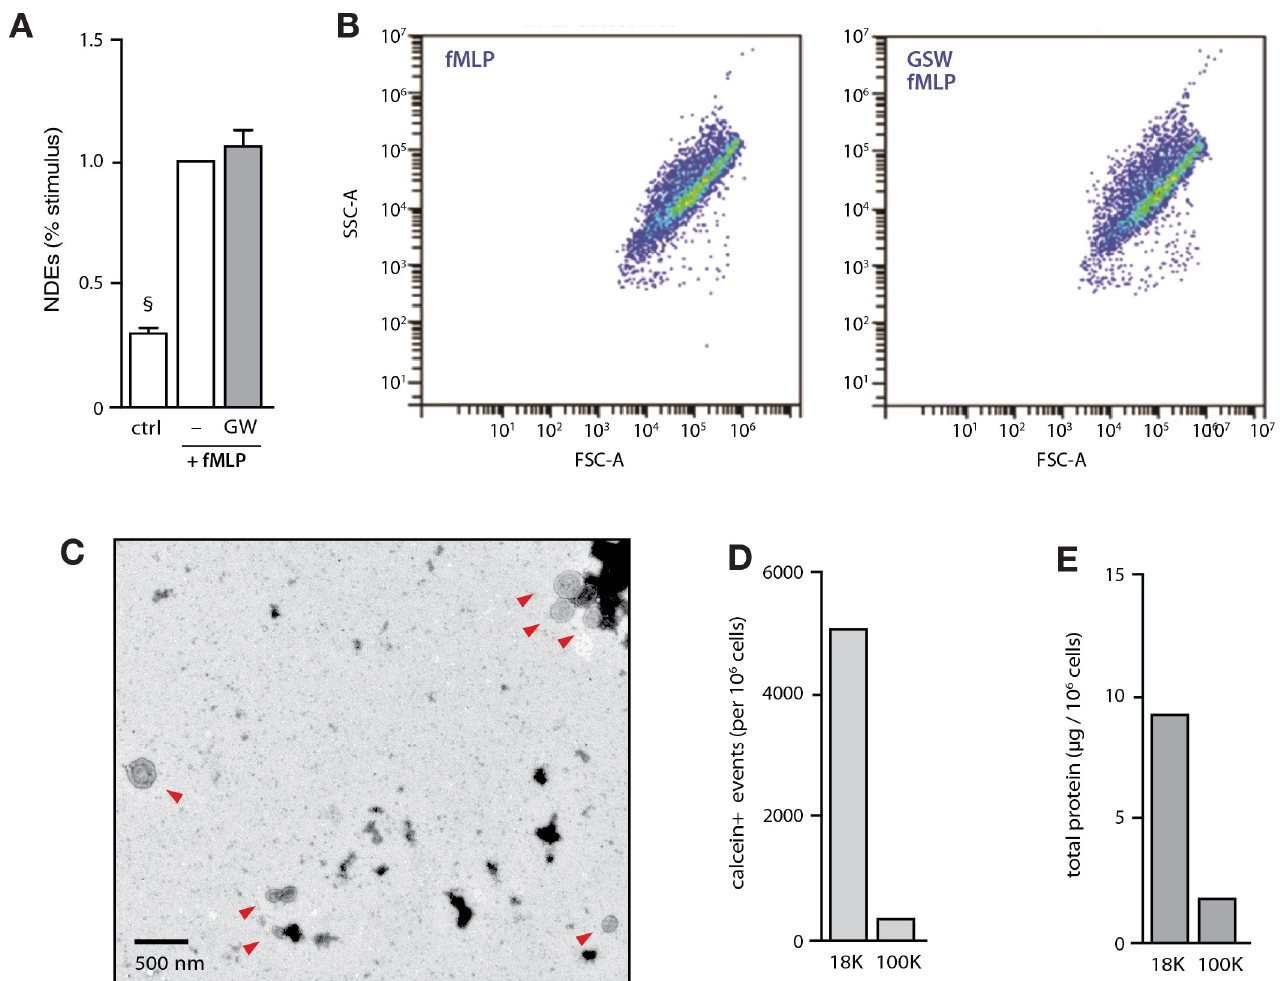
Figure 2. Isolation and properties of NDEs released by cultured neutrophils. ( A ) Neutrophils were cultured (15 min, 37 °C) in the presence of 20 µM GW4869 (or its diluent, 0.1% DMSO) prior to further incubation in the absence (“ctrl”) or presence of 100 nM fMLP for 120 min. Culture supernatants were collected, and NDEs were isolated and counted as described in Methods. Mean ± s.e.m. from 3 independent experiments. §, p < 0.01 vs fMLP-stimulated cells. ( B ) Detail of the flow cytometry analysis of the NDEs described in panel A, following the steps described in Figure 1A–C. Calcein Blue-positive events are shown. The experiment depicted is representative of three. ( C ) Transmission electron micrograph of isolated NDEs from fMLP-stimulated cells. Red arrows point to intact vesicles. The experiment depicted is representative of three. ( D ) Culture supernatants from neutrophils stimulated for 60 min with 100 nM fMLP were centrifuged at 1000 g; the resulting supernatants were centrifuged at 18,000 g and the pellets (“18K”) were processed for flow cytometry analysis of calcein-positive EVs as described in Methods. The 18,000 supernatants were further centrifuged at 100,000 × g (2 h, 4 ◦ C) and the resulting pellets (“100K”) processed for flow cytometry analysis of calcein-positive EVs. The experiment depicted is representative of three. ( E ) Samples depicted in panel D were also analyzed for total protein determination in Bradford